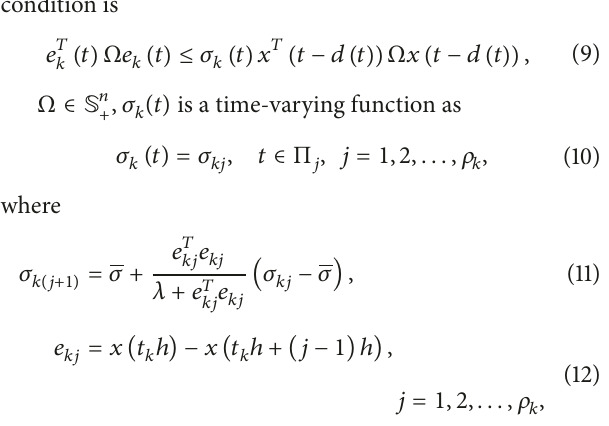
ℎ is the current released time and 𝑘 ℎ = 𝑡 ℎ + 𝑛ℎ , 𝑘+1 𝑘